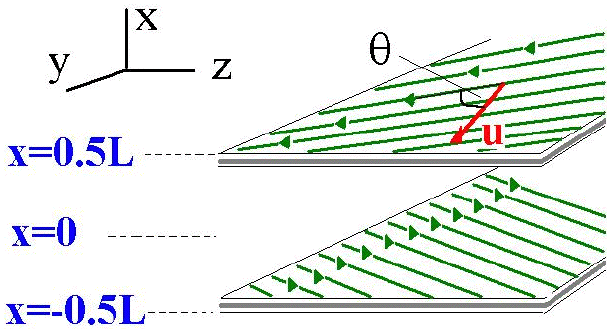
Fig. 1. The schematic of the magnetopause sheared magnetic field geometry (fluctuating field not shown).